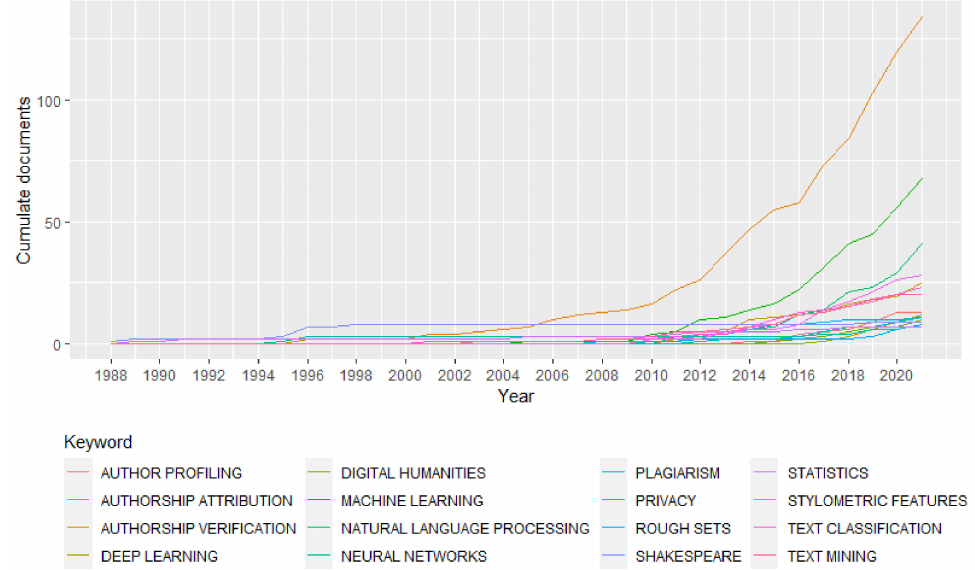
Figure 9. Author keywords dynamic view over